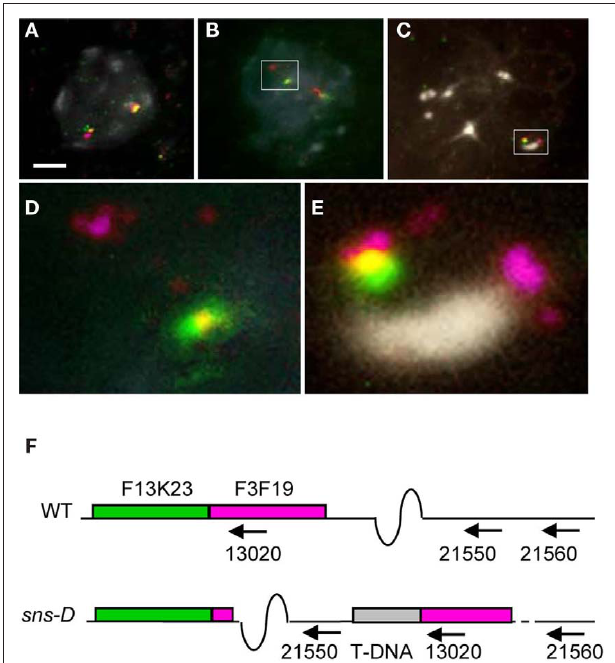
FIgURe 3 | Fluorescence in situ hybridization (FISH). Nuclei from wild-type (A) and sns-D (B,C) plants were stained with DAPI and hybridized with BAC F13K23 (green signal) and BAC F3F19 (magenta signal). The boxed areas of (B,C) are shown enlarged in (D,e) , respectively. The bar in (A) is 2.5 μm. (F) Schematic representation of the At1g13020 region on chromosome 1 in sns-D . The two BAC clones BAC F13K23 (green box) and BAC F3F19 (magenta box) are located adjacent on the wild-type chromosome 1, but discontinuously on the other chromosome 1 of the sns-D mutant. Due to a chromosomal rearrangement, the T-DNA and vector (gray bar) are located between the genes At1g21550 and At13020.